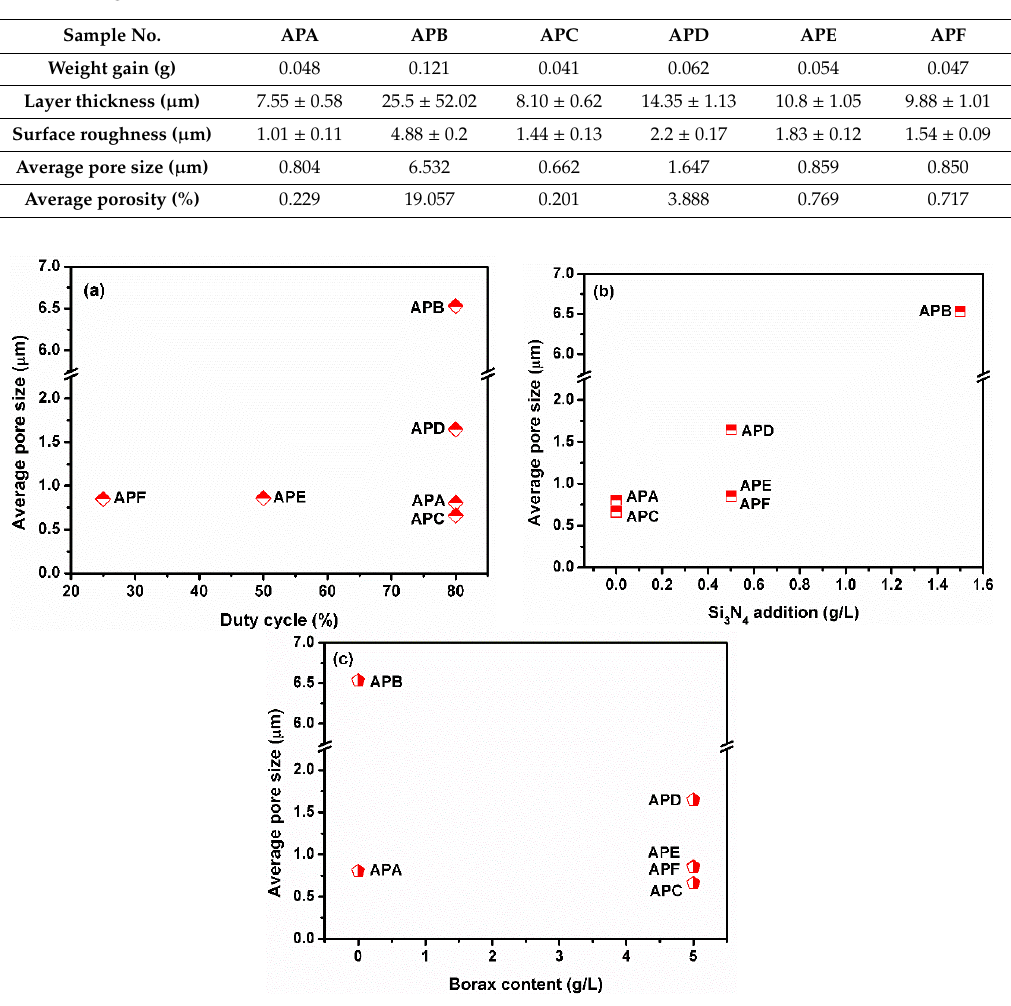
Figure 8. The correlation between average pore size and ( a ) duty cycle, ( b ) Si 3 N 4 and ( c ) borax